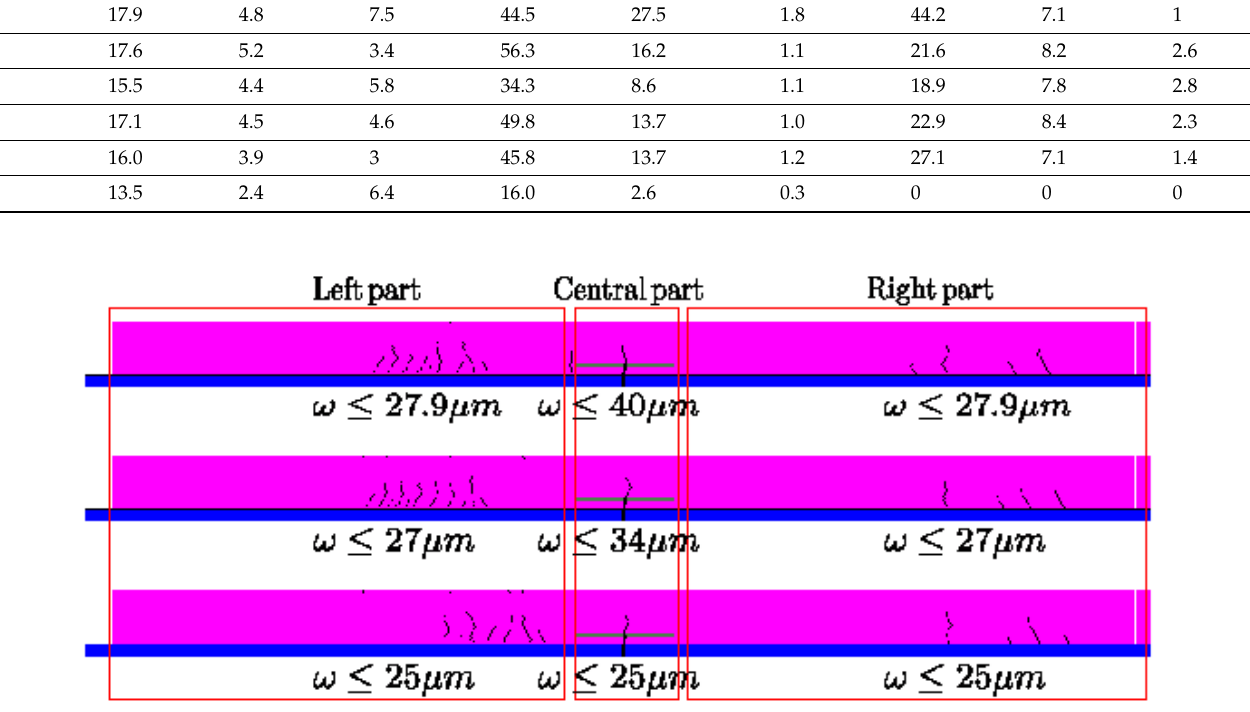
Figure 3. Example of cracking patterns related to technical solution n ◦ 15—3 different simulations.